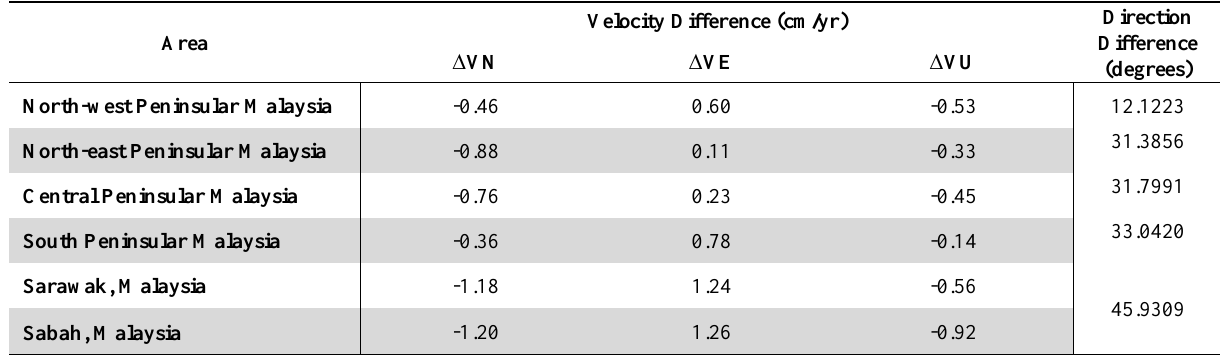
Table 4. Velocity and direction differences between 2001-2004 and 2008-2011 periods